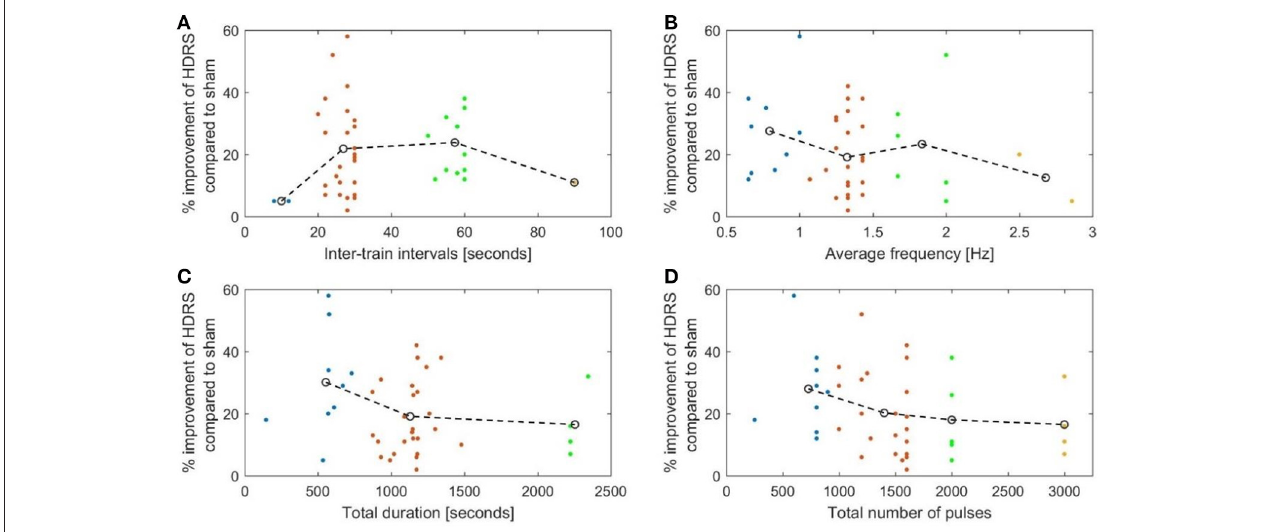
FIGURE 5 | The percentage reduction of the Hamilton depression rating score compared to sham plotted against. (A) The duration of the inter-stimulation intervals ( R 2 = 0.147). (B) The average stimulation frequency ( R 2 = 0.143). (C) The total duration of stimulation ( R 2 = 0.037). (D) The total number OF pulses ( R 2 = 0.113).